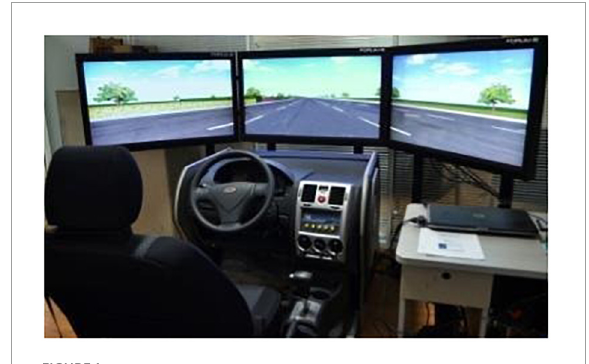
FIGURE1 The FORUM8 driving simulator used in this